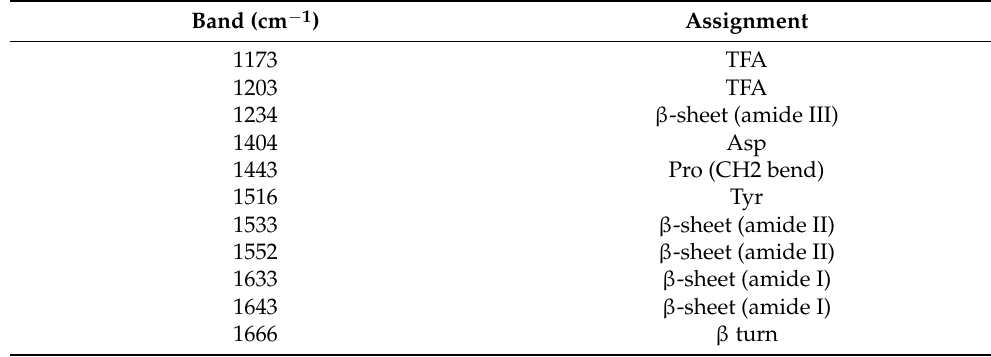
Table 1. Bands observed in the ATR FT-IR spectra obtained from thin films, containing suspensions of fibrils, produced by the AtPNP-A 36–69 and their tentative assignments. TFA: trifluoracetic acid. Band (cm − 1 ) Assignment 1173 TFA 1203 TFA 1234 β -sheet (amide III) 1404 Asp 1443 Pro (CH2 bend) 1516 Tyr 1533 β -sheet (amide II) 1552 β -sheet (amide II) 1633 β -sheet (amide I) 1643 β -sheet (amide I) 1666 β